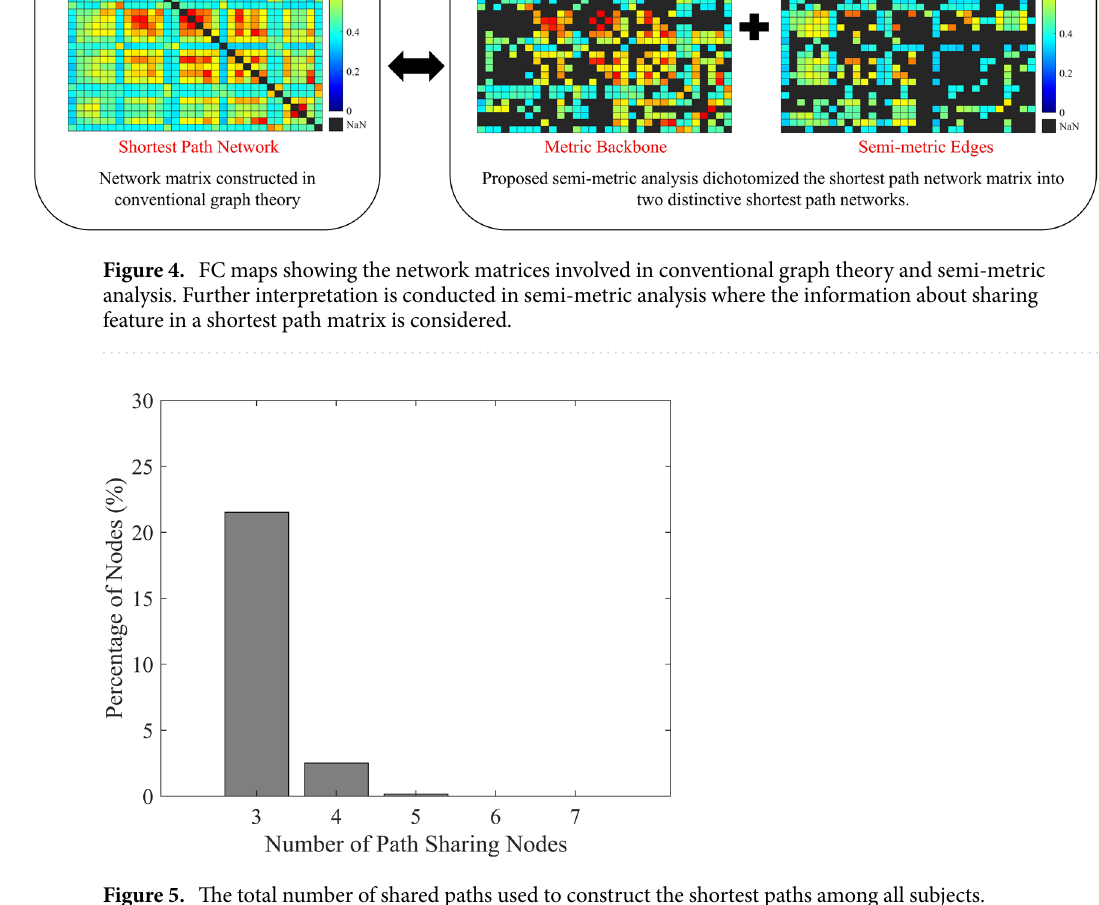
Figure 5. The total number of shared paths used to construct the shortest paths among all